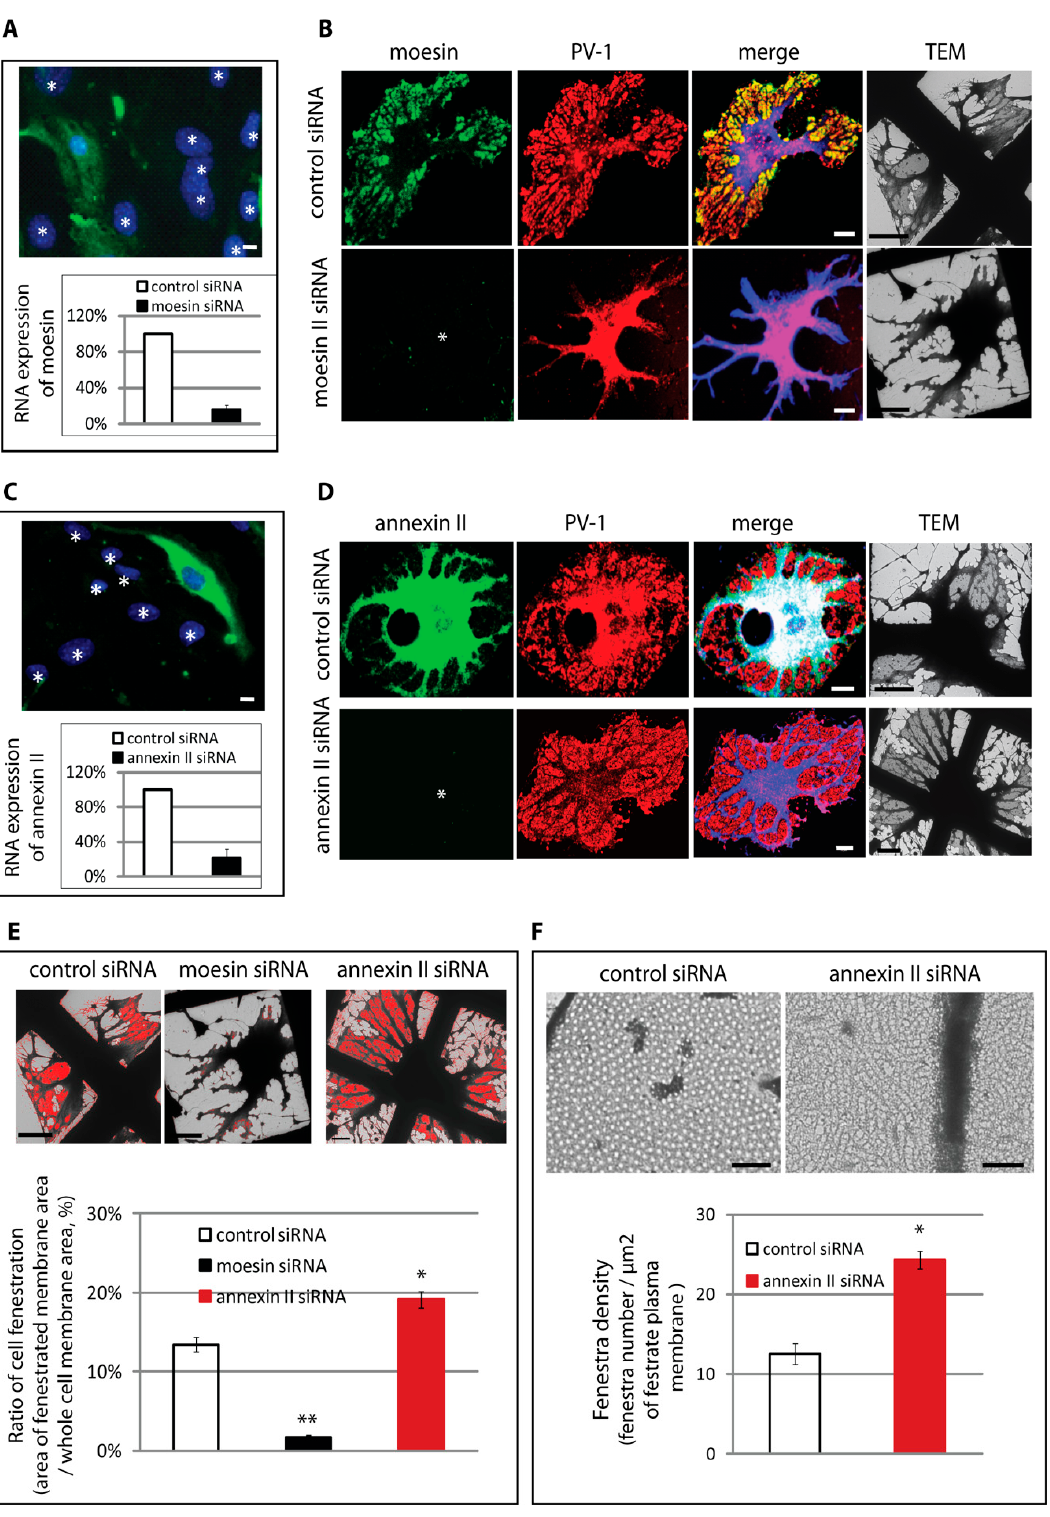
Figure 3. Moesin and annexin II differentially regulate fenestra formation. ( A ) Down-regulation of moesin by siRNA showed by immunostaining and qPCR analysis. The result was the average of 3 experiments ( n = 3); scale bar, 20 µm. ( B ) bEND5 cells transfected with control siRNA or moesin siRNA were induced with LtA for 3 h. The cells were fixed and immunostained for moesin, PV-1, and β -tubulin, before being prepared for correlative light–electron microscopy. In control siRNA transfected cells, moesin and PV-1 colocalised in sieve plates, while moesin knockdown resulted in the failure of PV-1 redistribution to sieve plates and the cells maintained their normal stellate morphology. Wholemount TEM revealed the lack of fenestrated plasma membrane in moesin